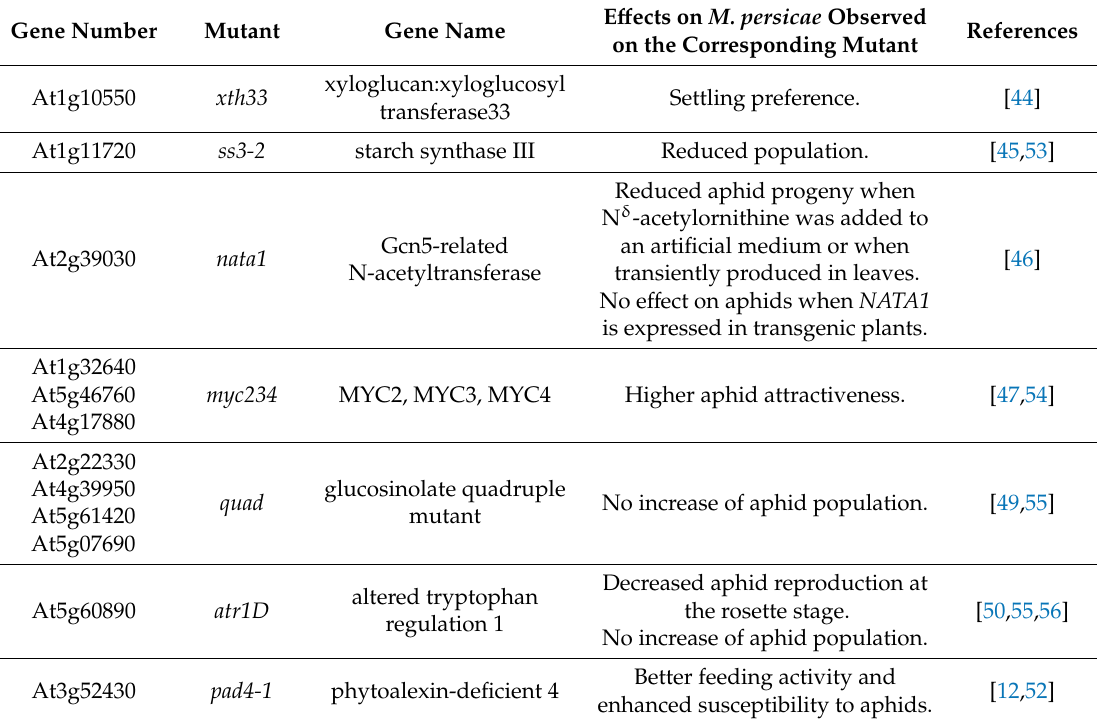
Table 1. Myzus persicae fitness and behavior on the A. thaliana mutants used in this study. E ff ects on M. persicae Observed Gene Number Mutant Gene Name on the Corresponding